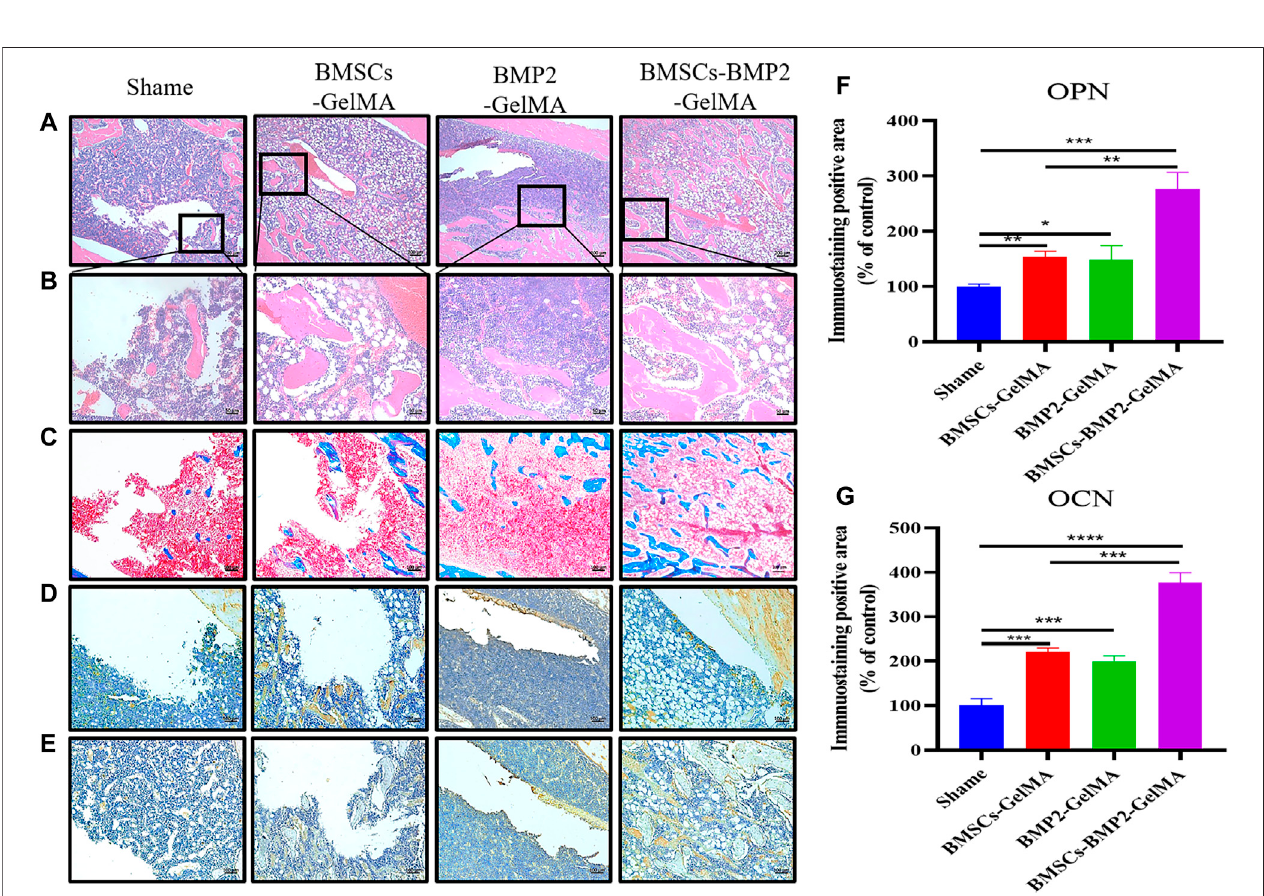
FIGURE 7 | HE staining (A) (bar = 200 μ m), (B) (bar = 50 μ m) and Masson ’ s trichrome staining (C) (bar = 100 μ m) images of bone defects 8 weeks after implantation of respective scaffolds. Immunohistochemical staining of OPN (D) (bar = 100 μ m) and OCN (E) (bar = 100 μ m) in rat femoral defect area 8 weeks after implantation of scaffolds. Quantitative analysis of particles with Immunohistochemical staining of OPN (F) and OCN (G)